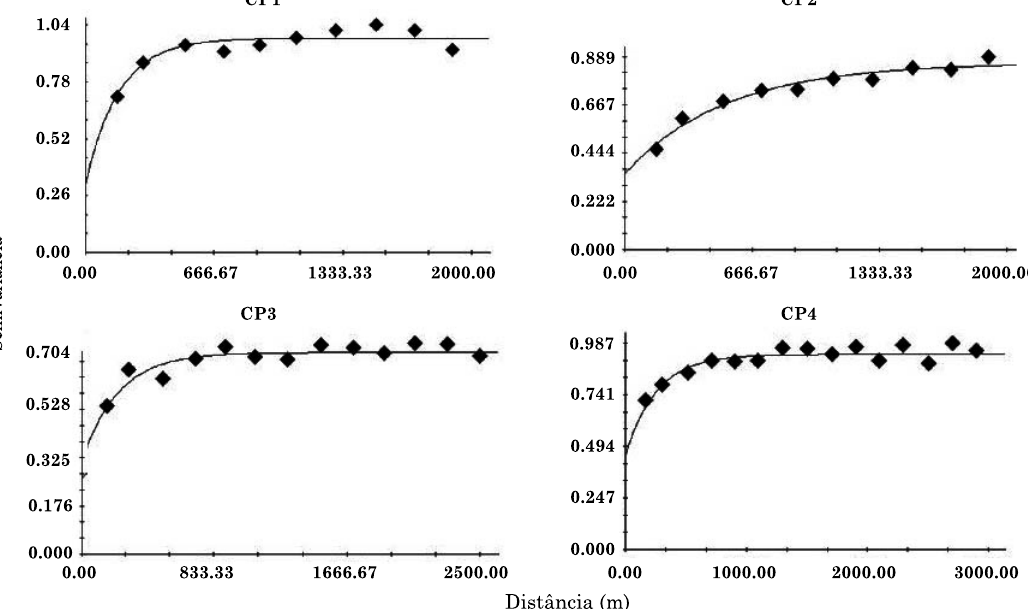
Figura 3. Semivariograma de cada componente principal (CP1: componente principal 1; CP2: componente principal 2; CP3: componente principal 3; CP4: componente principal